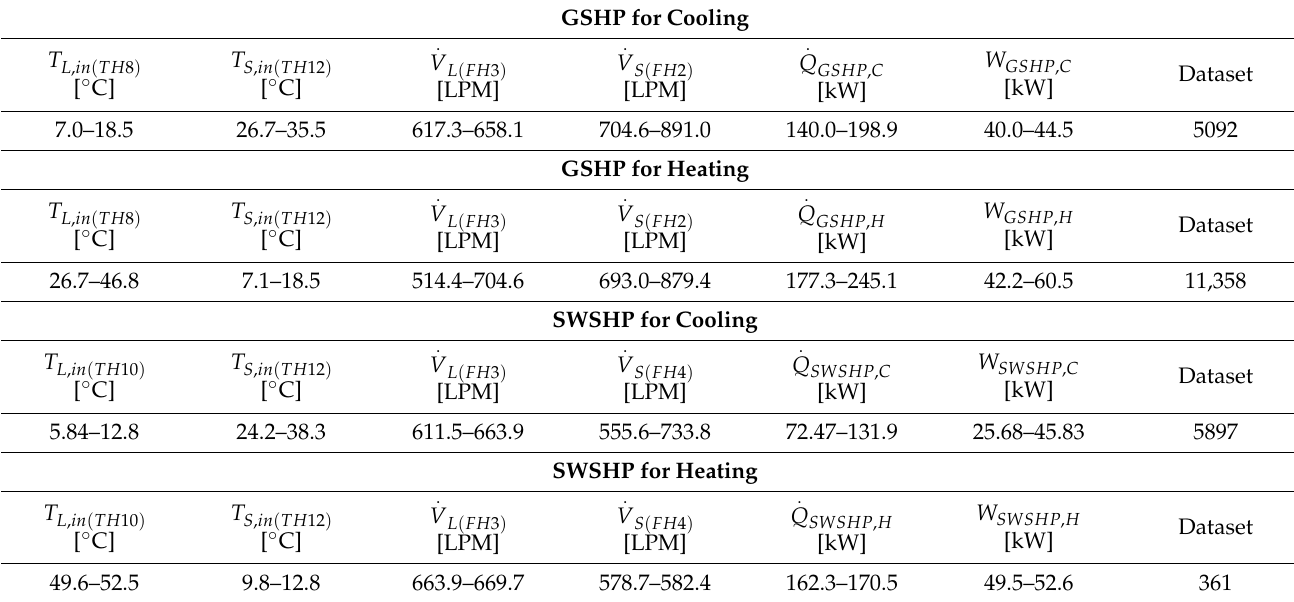
Table 4. Variation range of the measurement sensors and data.